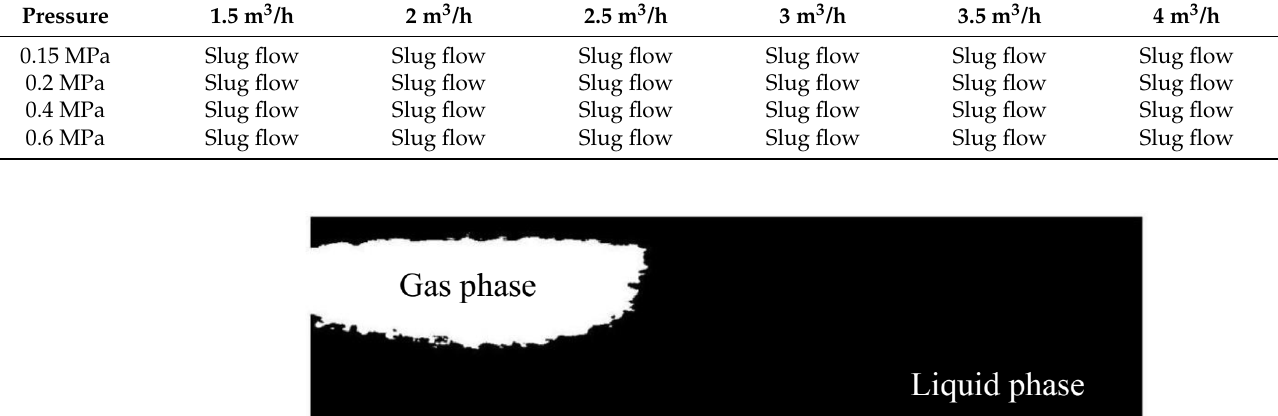
Figure 8. Probability density function of inclined upward by 10°.